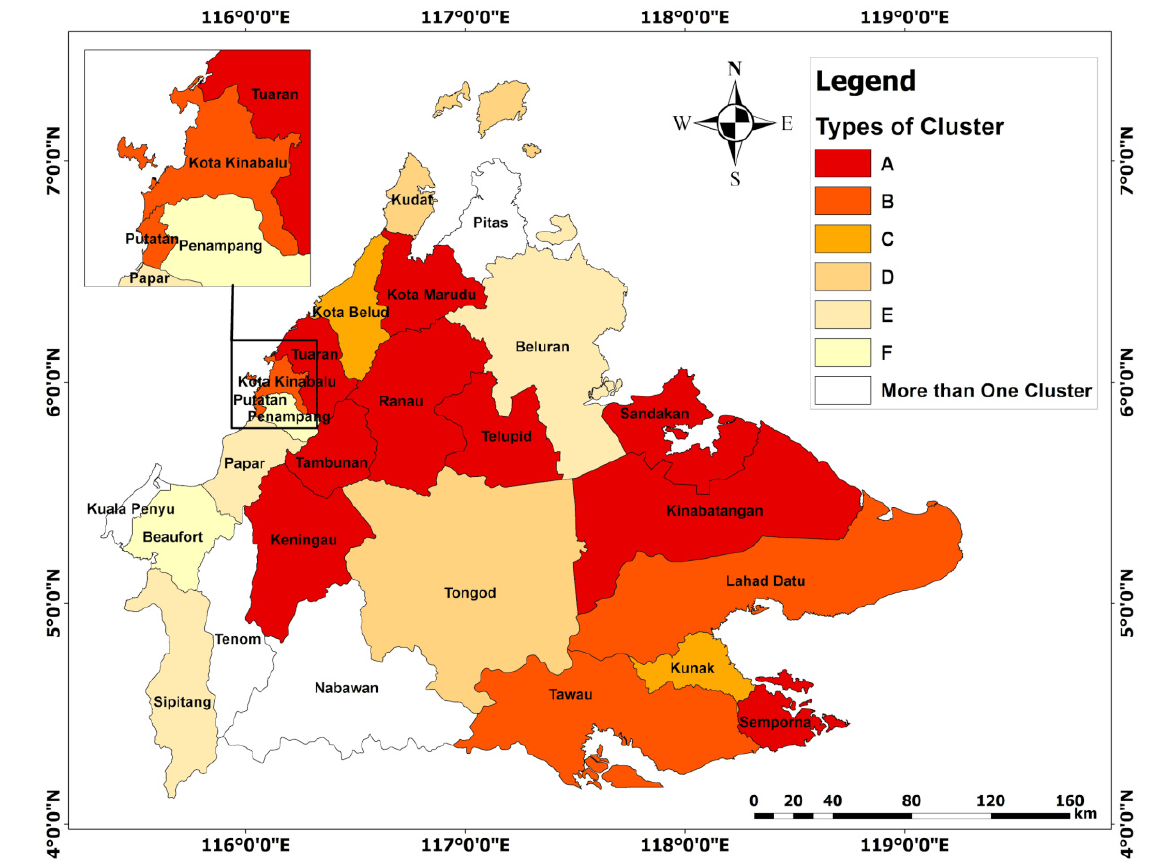
Figure 5. Cluster dominance of each district in Sabah.